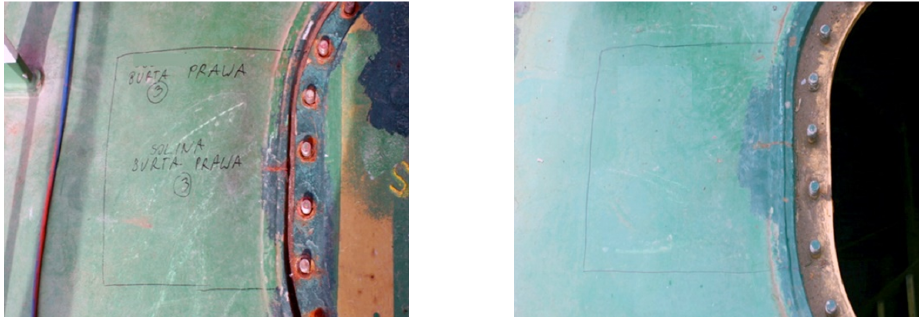
Figure 6. The sections of the manhole structure cut out for examination (handy-size bulk carrier 30182 DWT). Macroscopic examination.